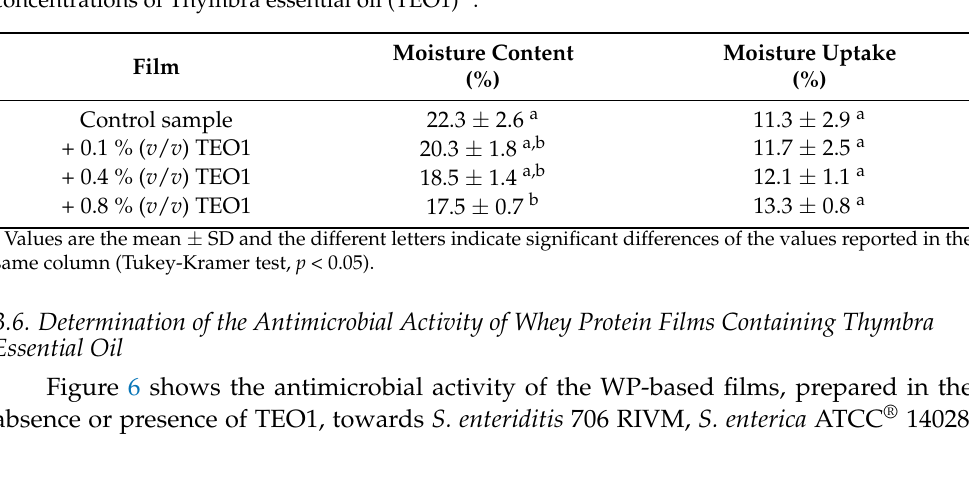
Table 3. Moisture content and uptake of WP (500 mg)-based films prepared containing or not different concentrations of Thymbra essential oil (TEO1)